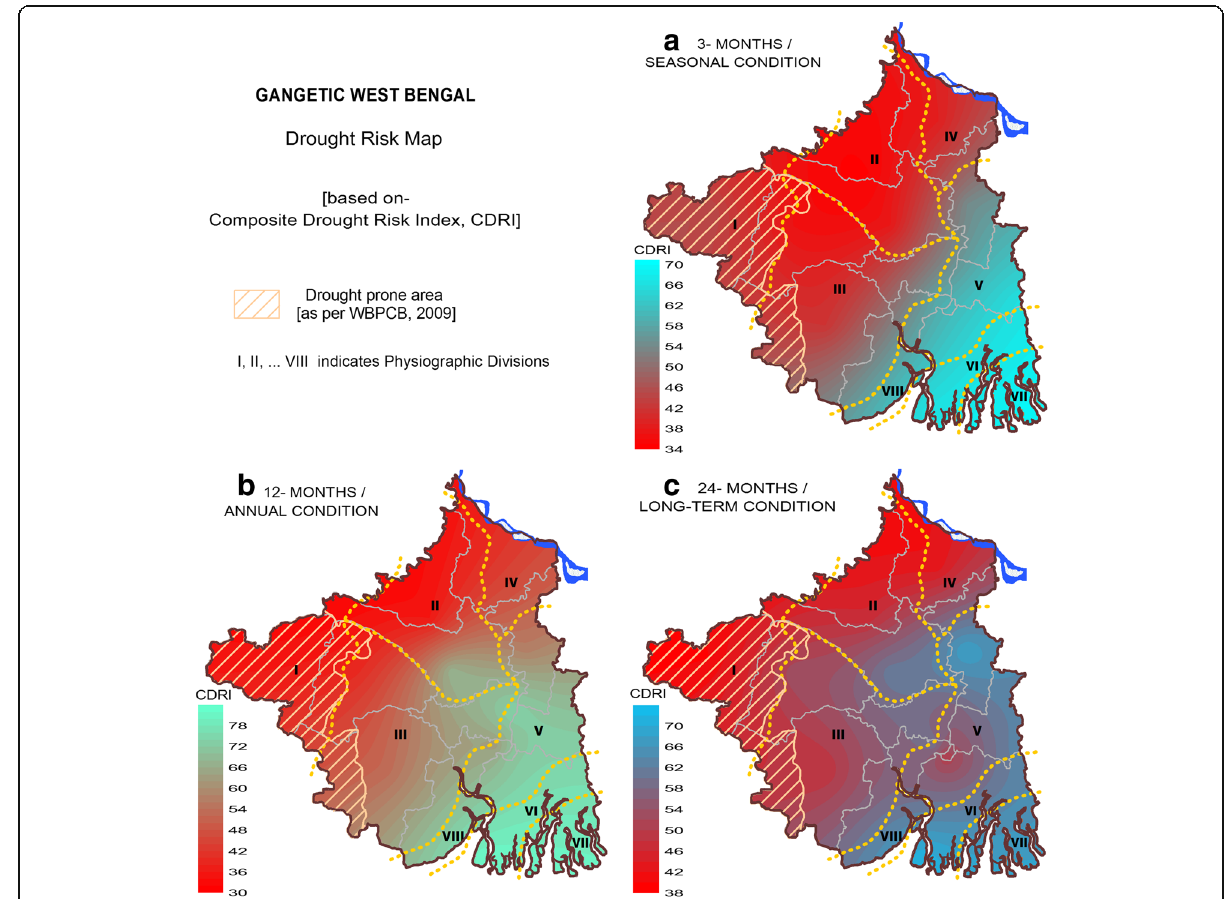
Fig. 17 Drought risk maps for the GWB at ( a ) 3- month and ( b ) 12- month and ( c ) 24- month time